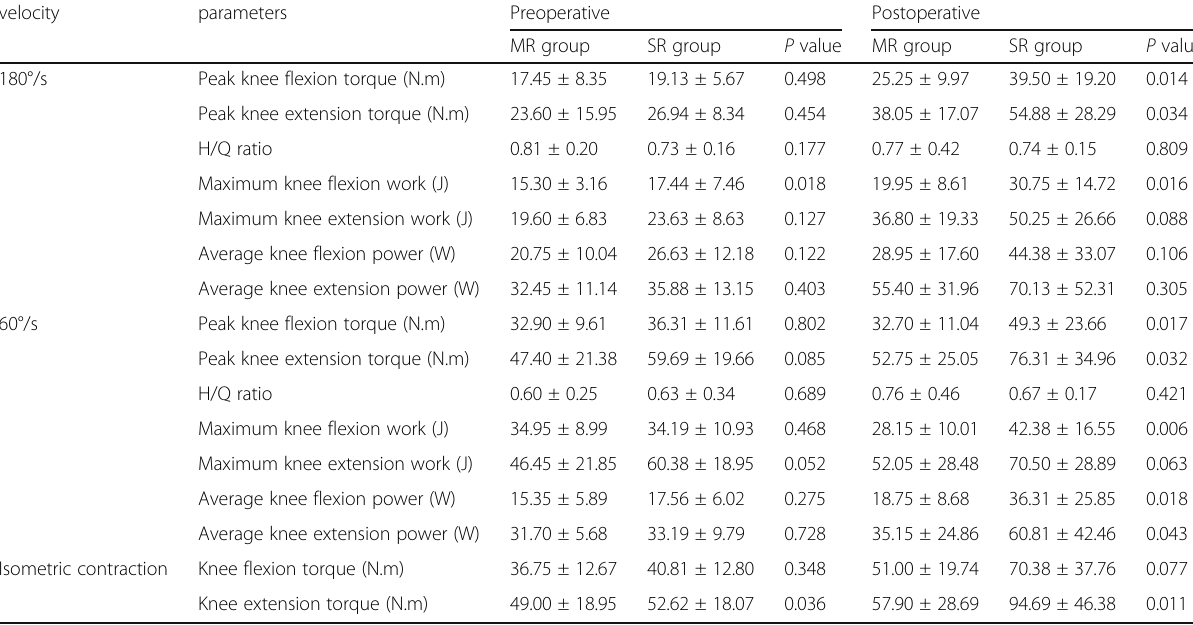
Table 3 Isokinetic and isometric parameters (mean ± SD) between groups before and after TKA velocity parameters Preoperative